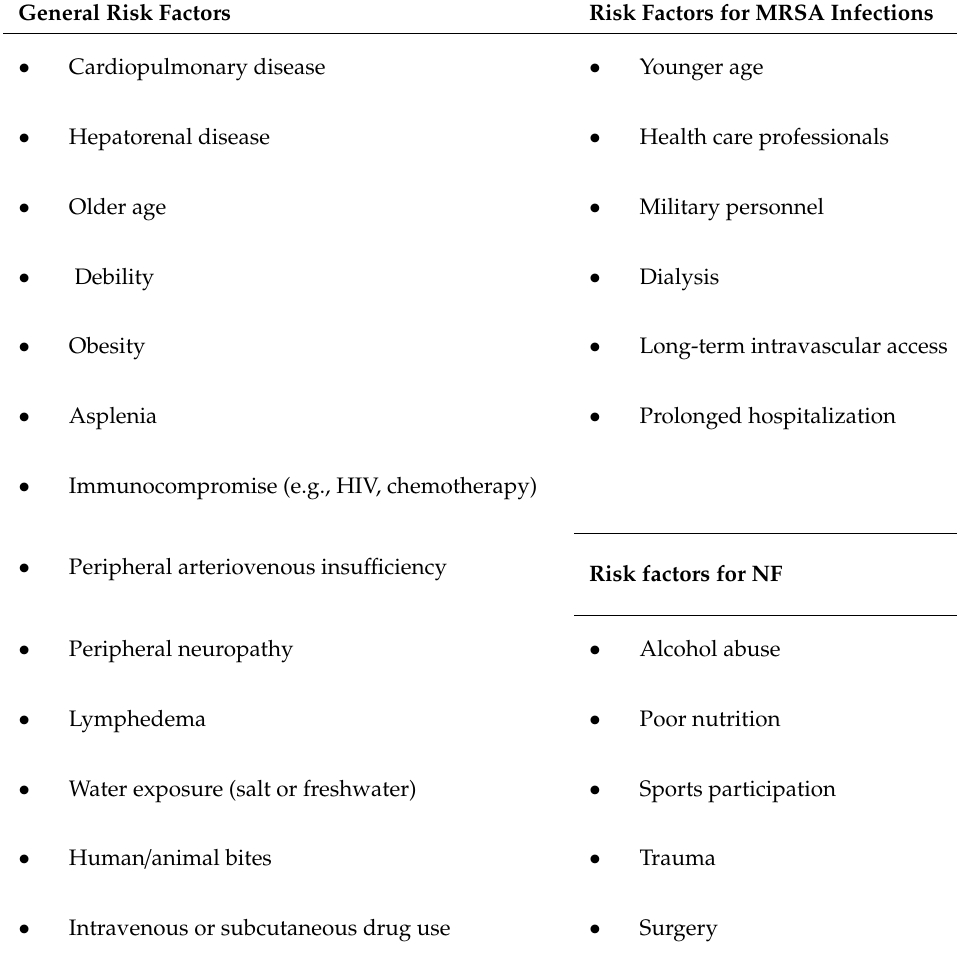
Table 1. Risk factors for skin and soft tissue infections